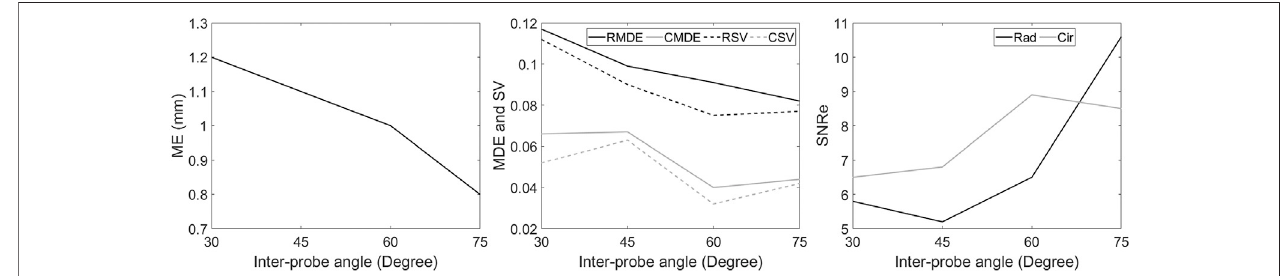
FIGURE 9 | Comparison between different relative angle datasets using multi-perspective unit axial vectors based compounding (VC). The Mean error (ME) of the tracking performance ( left ), the mean drift error (MDE) and strain variability (SV) of radial and circumferential strain at end-diastole ( middle ), the elastographic signal-to- noise ratio (SNRe) at the end-systolic radial and circumferential strain ( right ).